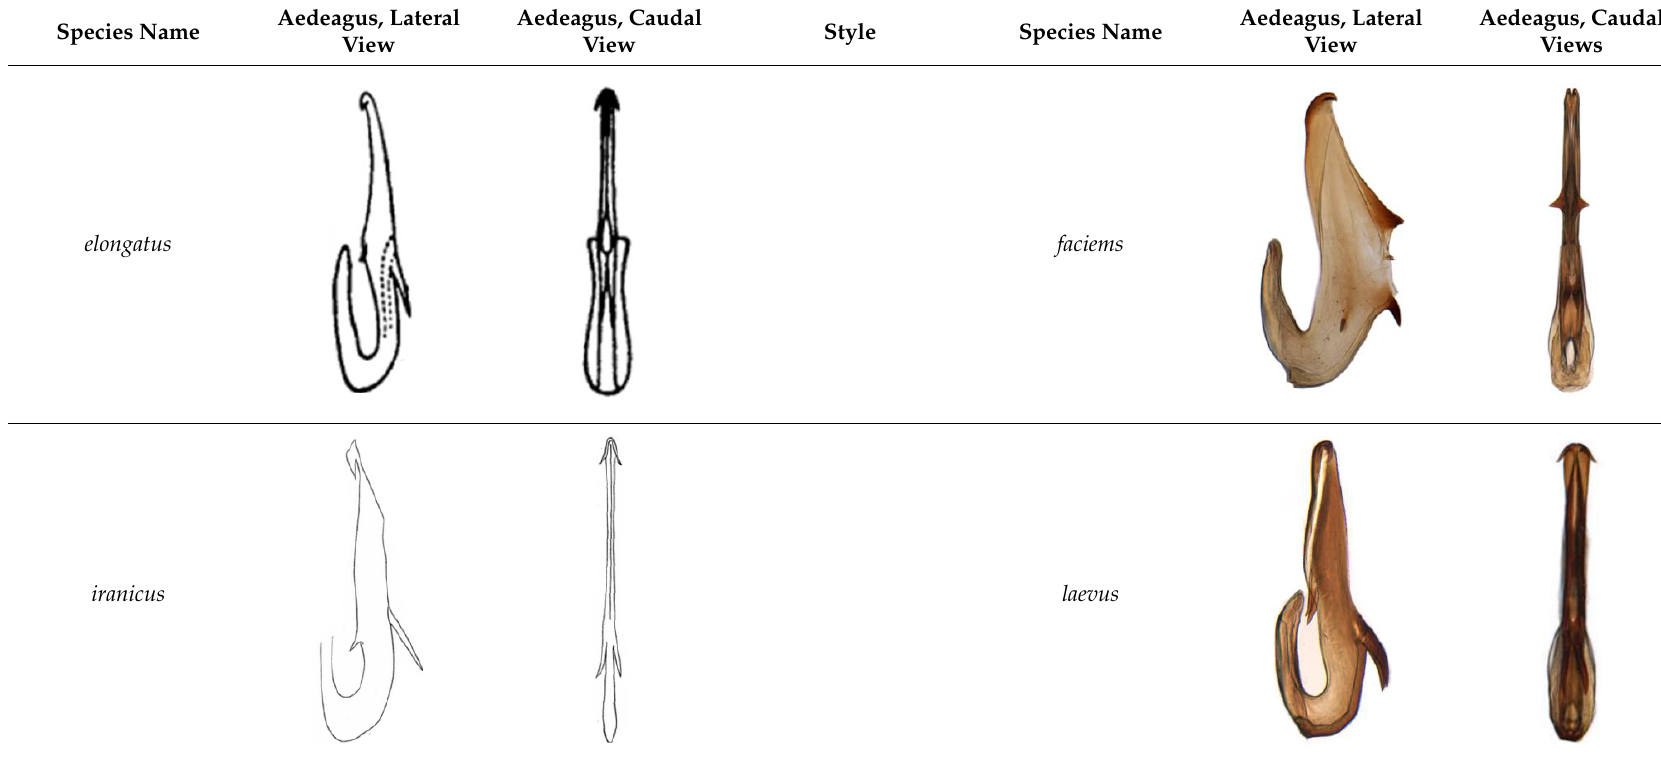
Table 2. Comparative morphology of Aedeagus and style of Planaphrodes (the styles of some species were not provided in the references) . Species Name Aedeagus, Lat- eral View